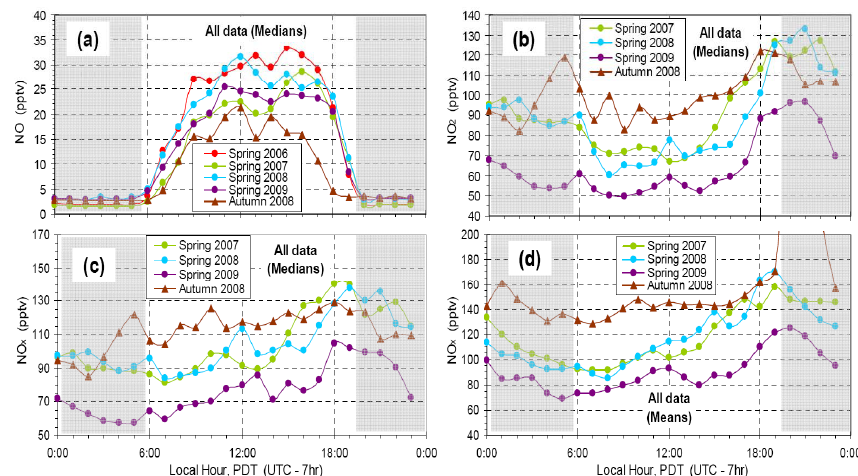
Fig. 3. Median diurnal cycles for (a) NO, (b) NO 2 and (c) NO x for the four seasons presented in this paper. The mean diurnal cycle in NO x is shown in (d) . For clarity, we have truncated the y-axis at 200pptv, but the 20:00–22:00PDT mean NO x values are 337, 596 and 229pptv, respectively. Gray shading indicates time between local sunset and local sunrise.